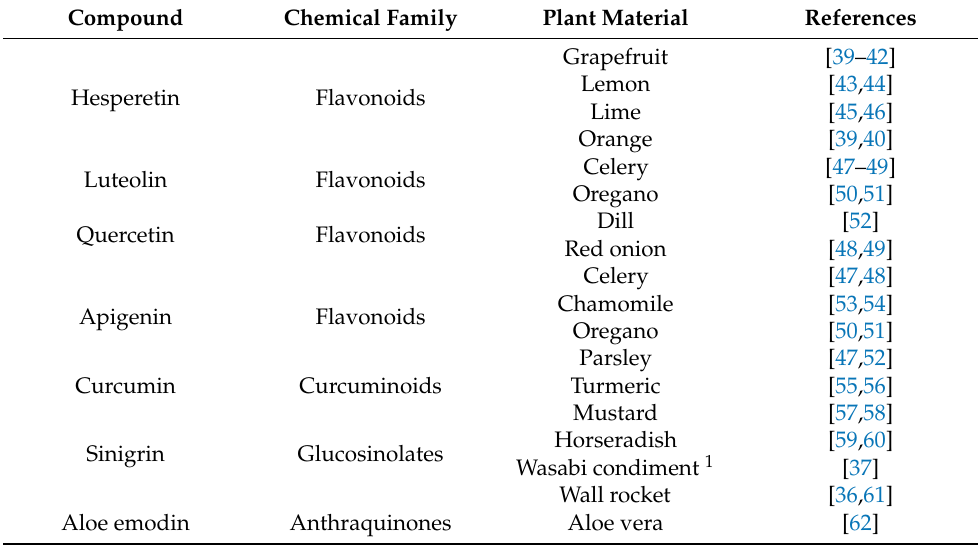
Table 1. Selected phytochemical compounds reported as potential natural inhibitors of SARS-CoV-2 3CL Pro activity and naturally present in the plant materials used in the current